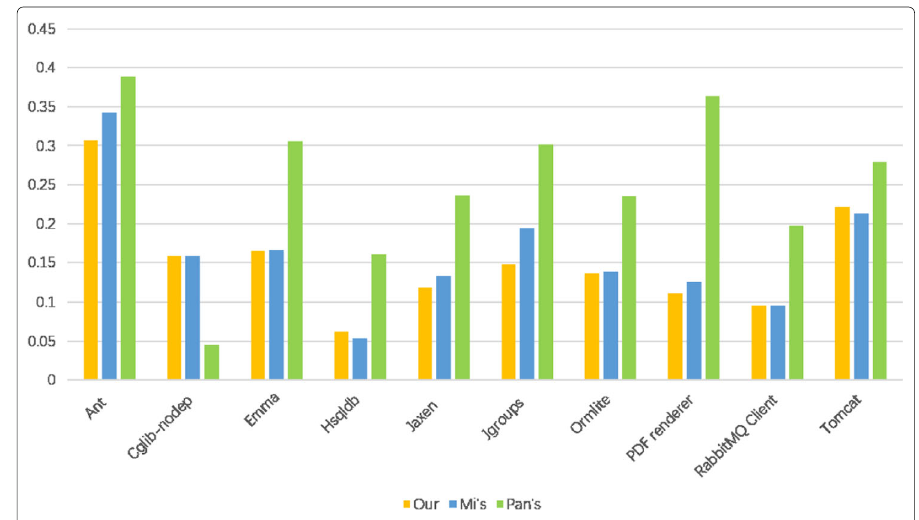
Fig. 5 The value of COUM